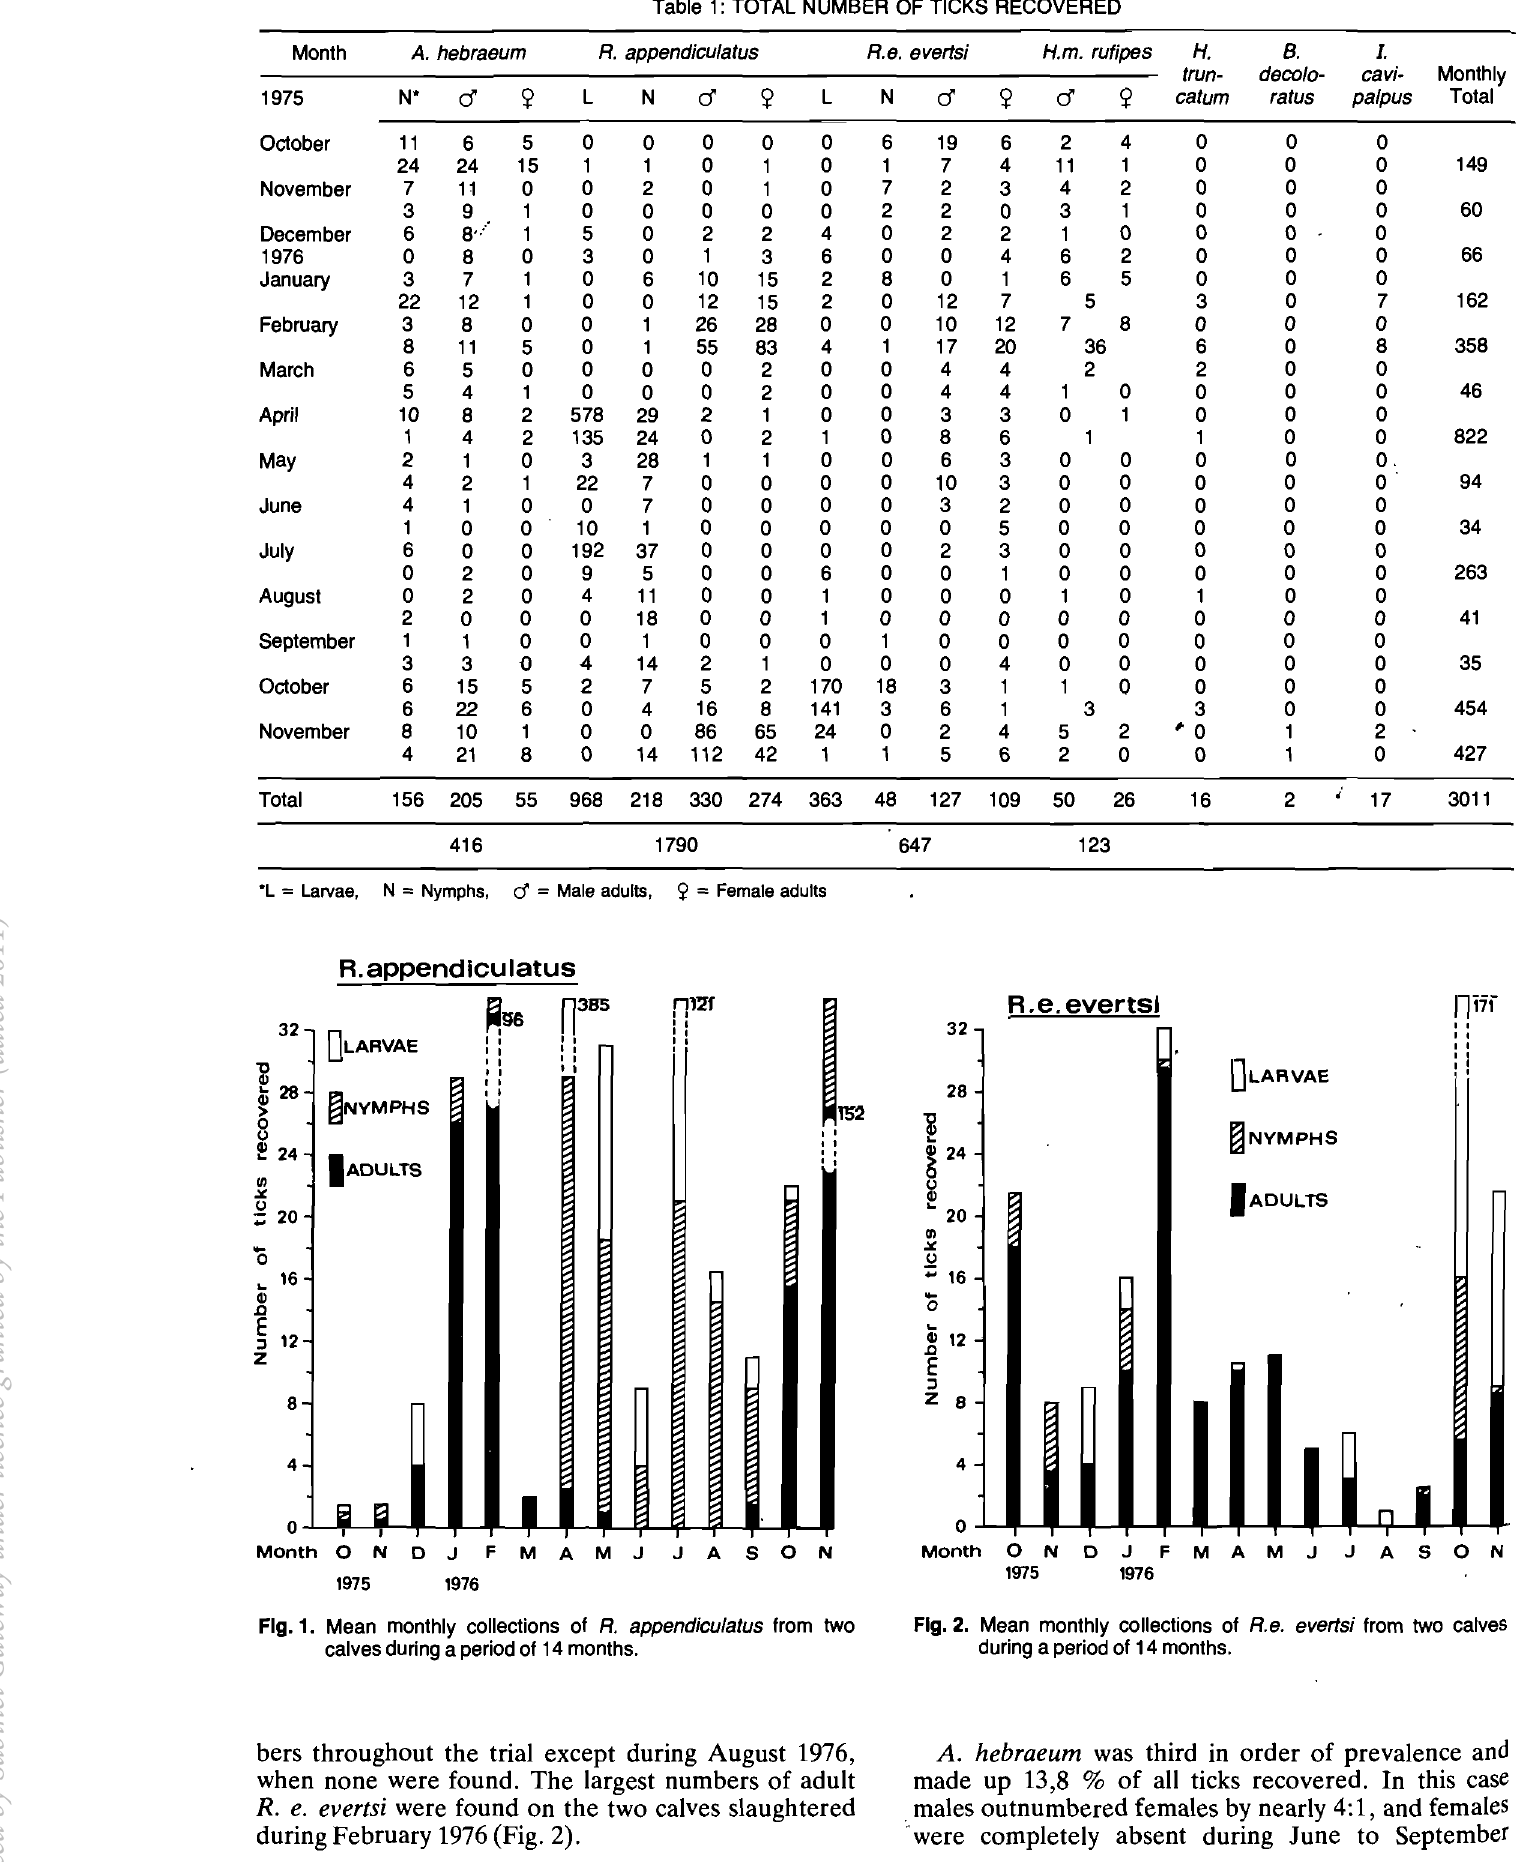
A. hebraeum was third in order of prevalence and made up 13,8 % of all ticks recovered. In this case . males outnumbered females by nearly 4:1, and females were completely absent during June to